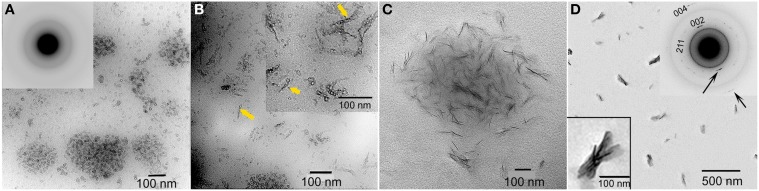
TEM micrographs of calcium phosphate mineral products formed in the presence of 2 mg/ml recombinant full-length amelogenin, rP172, examined at selected times: 15 min (A), 45 min (B), 1–4 h (C), and 1 d (D). ACP particles seen at 15 min (A, inset) were found to align to form need-like particles (arrows) at 45 min (B). After 1 d, based on selected area electron diffraction analyzes (D, inset), aligned bundles of needle-like apatitic crystals were formed. This image was reproduced from Kwak et al. (2009).